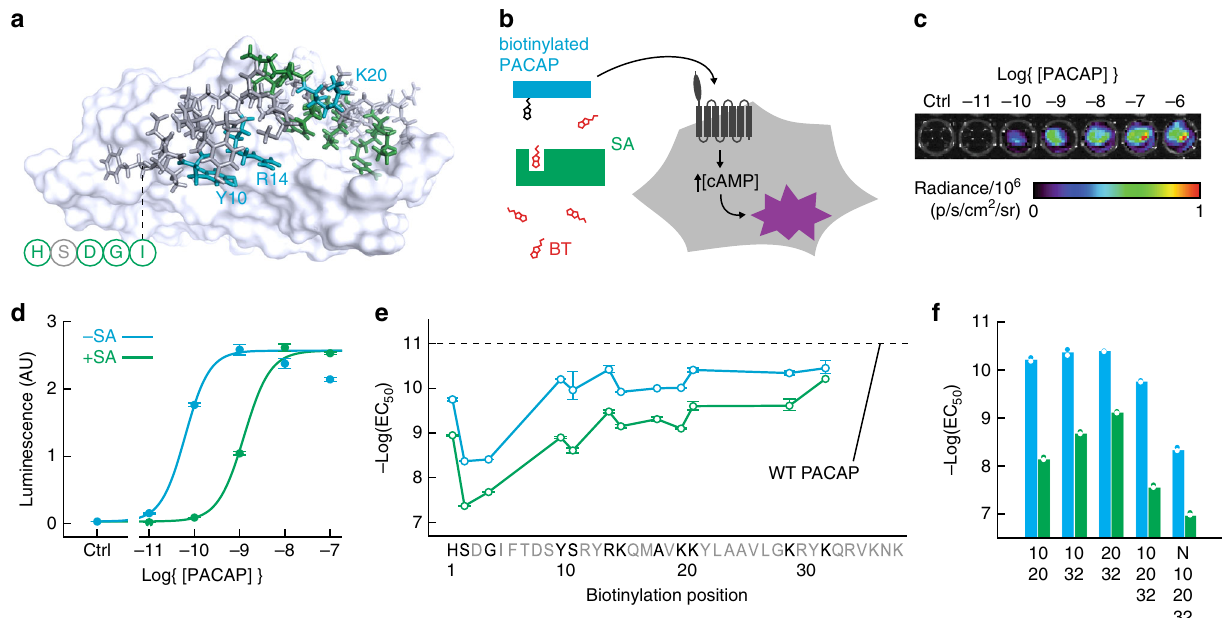
Fig. 2 Engineering a PACAP-based AVATar. a Identi fi cation of candidate ligand attachment sites on PACAP: Structure of PACAP in complex with a PAC1 receptor fragment 18 , highlighting residues whose substitution blocks (green) or does not affect (blue, labels) peptide bioactivity, according to previous structure-activity studies. N-terminal residues absent from the structure indicated schematically (circles). b Schematic of PAC1-based bioassay for testing biotinylated PACAP constructs (blue), their blocking by streptavidin (green), and release by free biotin (red). Unblocked PACAP derivatives can bind the PAC1 receptor (dark gray) expressed in CHO cells, triggering cAMP production and activating a luminescence reporter (purple). c Raw luminescence recorded from the assay cells under titration with wild type PACAP. d Quanti fi cation of luminescence output and determination by curve- fi tting of EC 50 values for a biotinylated PACAP derivative (PACAP-10-BT) in the presence (green) and absence (blue) of 200 nM streptavidin (SA). e Screening for PACAP residues that tolerate modi fi cation: EC 50 values for receptor activation in the absence (blue) or presence (green) of SA by PACAP-biotin conjugates as a function of sequence position (untested positions in gray). EC 50 of wild-type (WT) PACAP indicated by the dashed line. f EC 50 values of multiply biotinylated PACAP conjugates modi fi ed at the positions noted (N = N-terminus), in the absence (blue) and presence (green) of SA. Error bars in d – e denote SD of duplicate